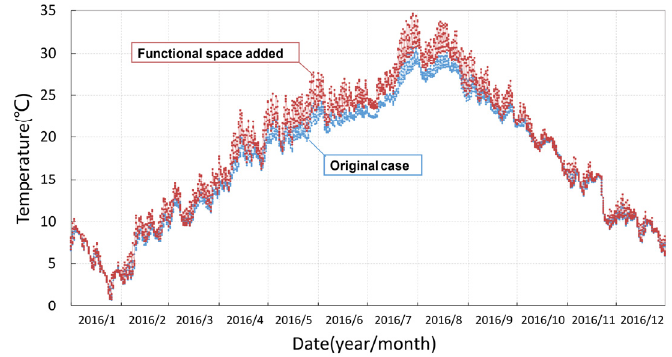
Figure 18. Comparison of air temperatures in the tomb chamber. Table 3. Statistics of the air temperature in the tomb chamber.